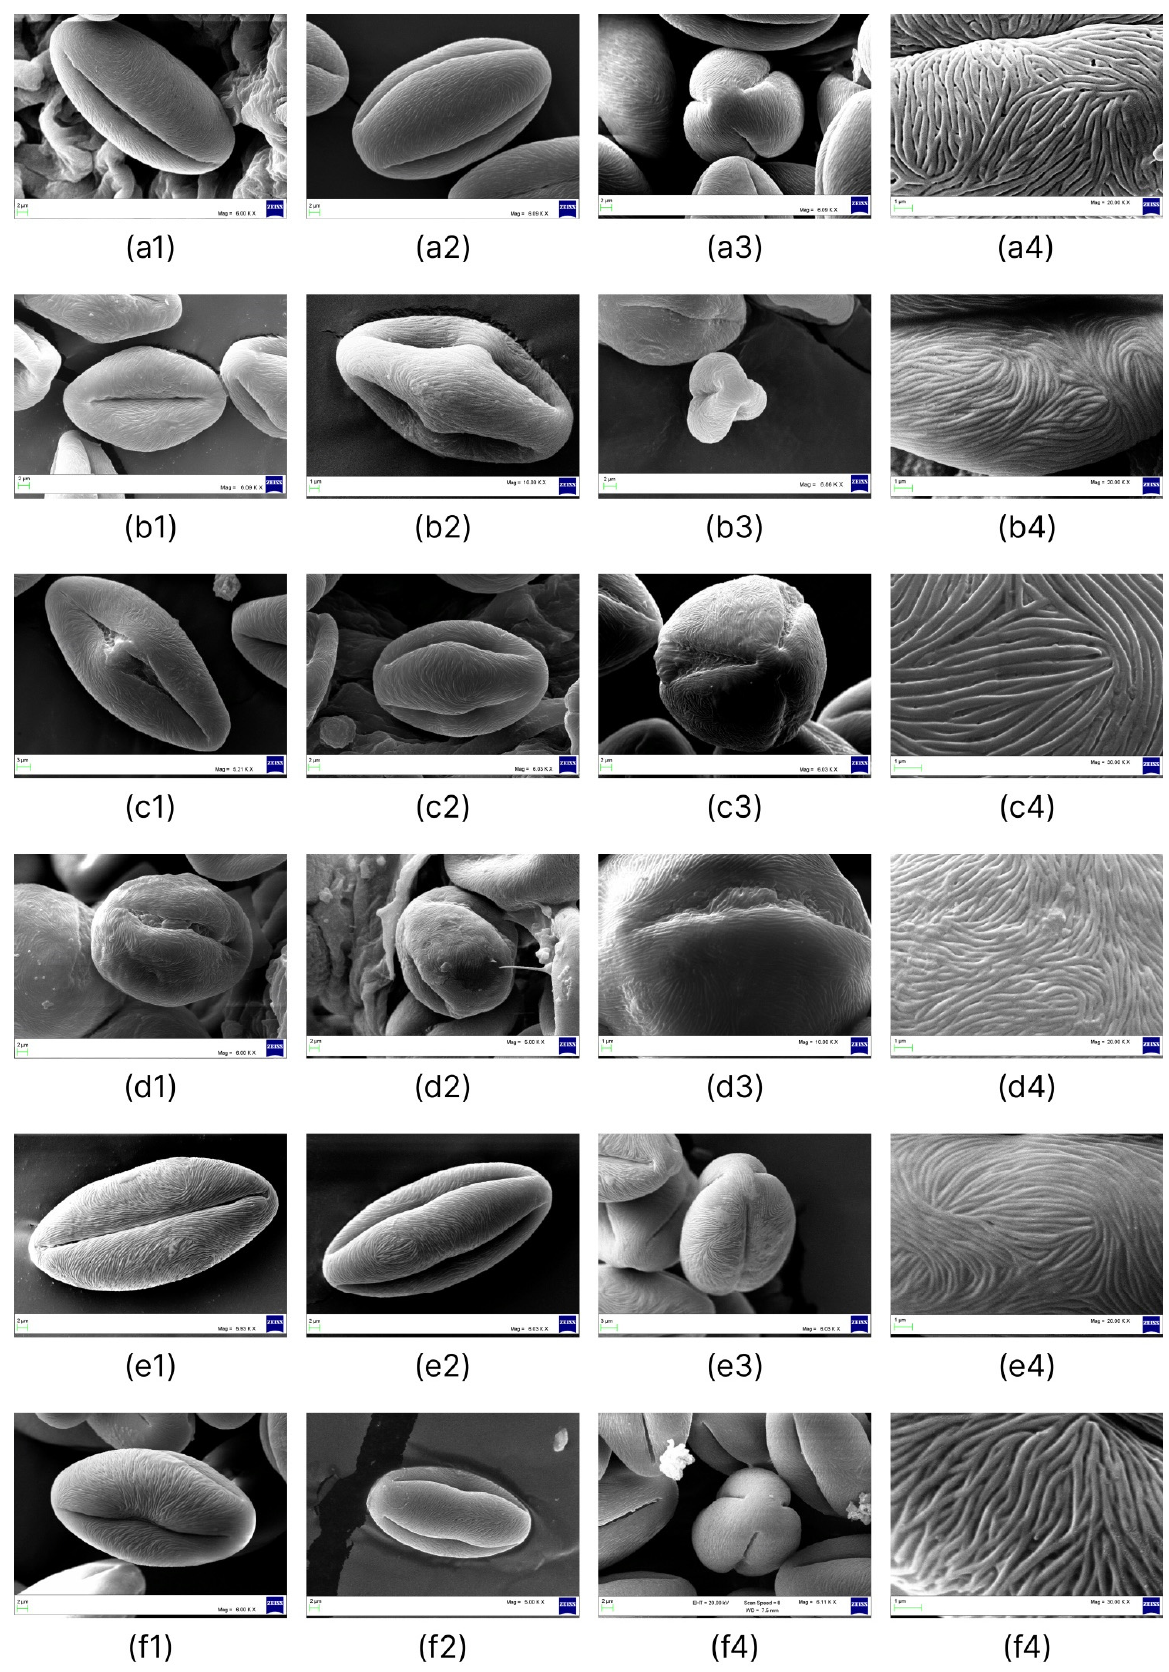
Figure 2. SEM micrographs of Nitraria pollen: N. sibirica : ( a1 ) equatorial view showing a colpus, ( a2 ) equatorial view in the mesocolpus area, ( a3 ) polar view, and ( a4 ) details of the exine